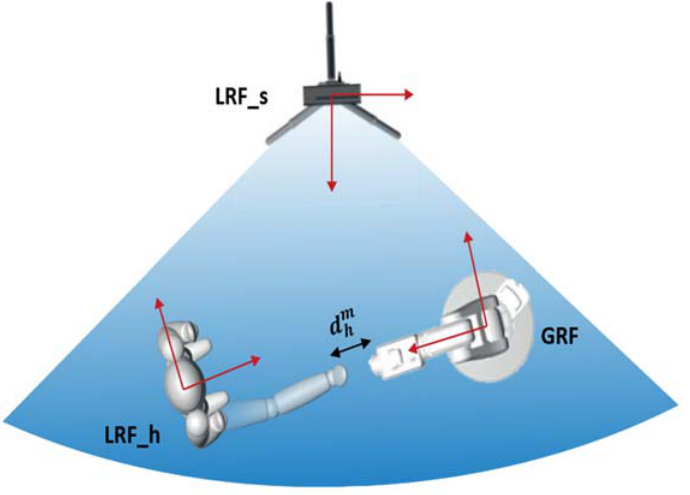
Figure 2. Multi-agent environment made up by: anthropomorphic robot (Global Reference Frame), human being (Local Reference Frame_human), and depth sensor (Local Reference Frame_sensor; 𝒅 𝒉𝒎 is the human–robot minimum computed distances.